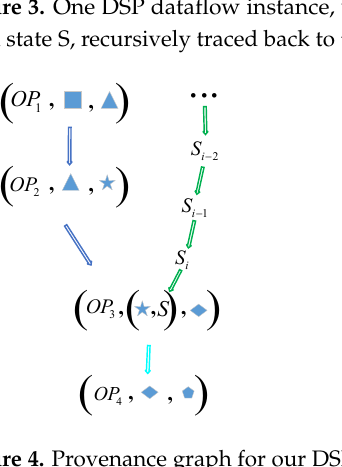
Figure 4. Provenance graph for our DSP